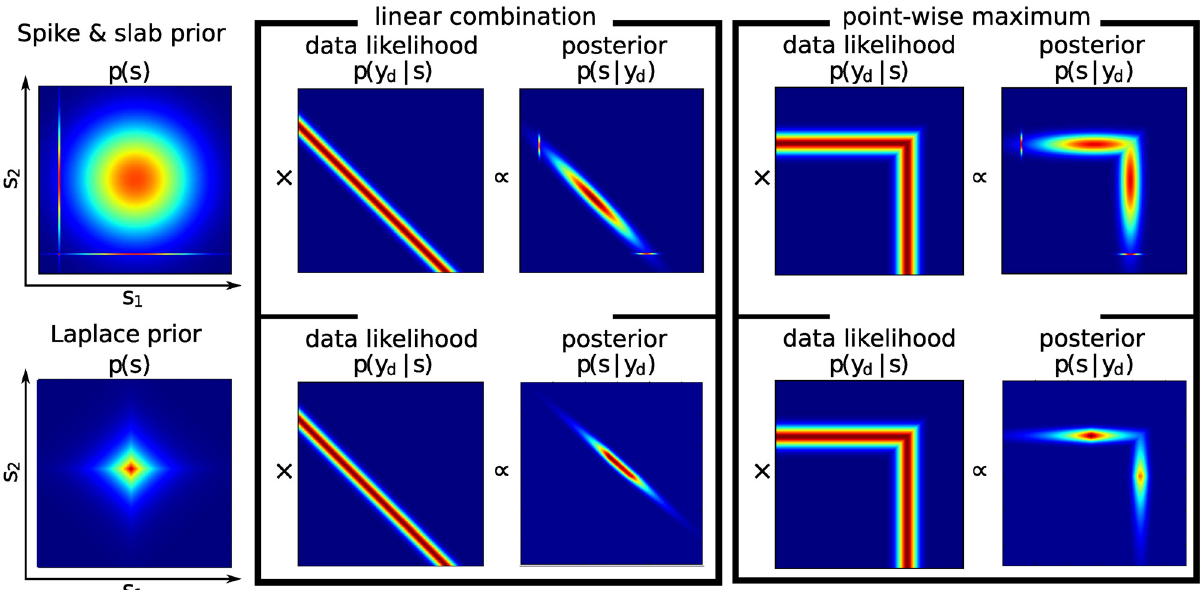
Fig 2. Illustration of choice of prior distribution and multimodality in the latent space. A H = 2-dimensional spike-and-slab and Laplace priors over latent variables and the multimodal posterior distribution induced by these priors for both linear and nonlinear data